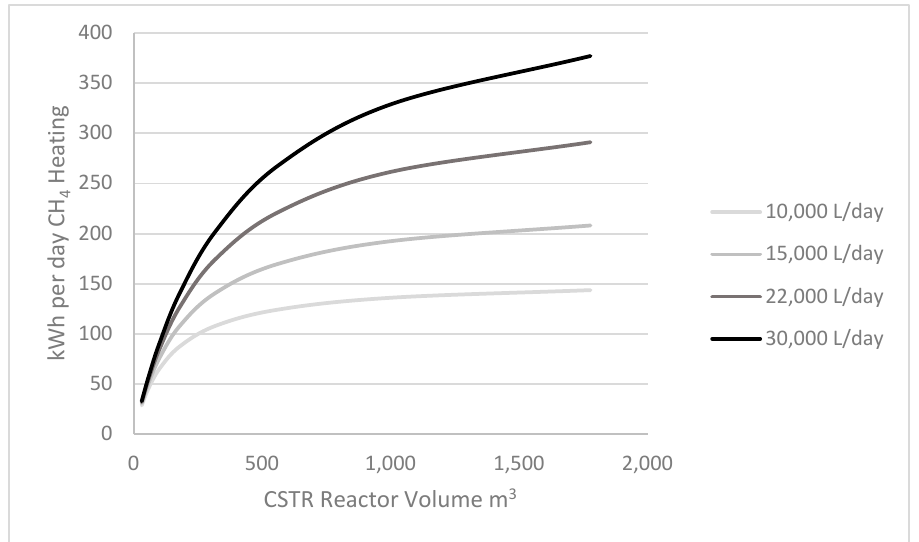
Figure 4. The biogas daily calori fi c heating is generated for di ff erent reactor volumes and e ffl uent loads.